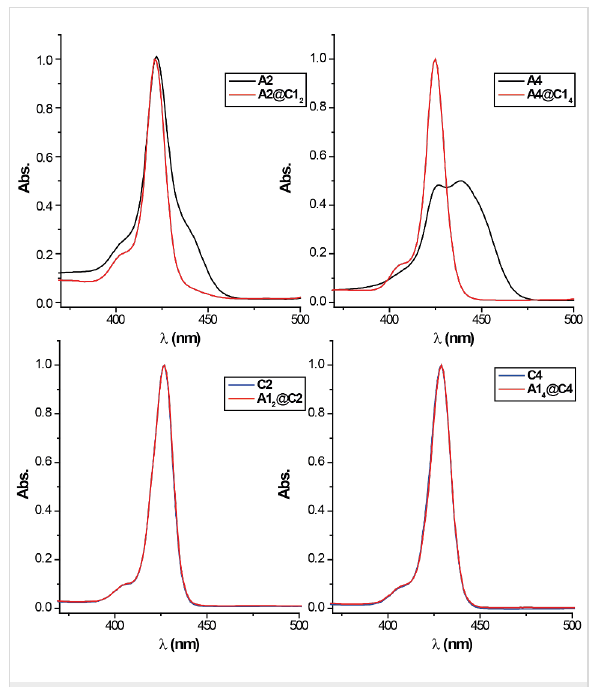
Figure 5: Normalized UV–vis absorption spectra (CH 2 Cl 2 , 3 μ M) of A2 , A4 , C2 and C4 and their complexes formed with the monovalent building blocks A1 and C1 showing no significant batho- or hypsochromic shift. Absorption spectrum of A4 was normalized to 0.5 because of the strong self-aggregation and the resulting broad Soret